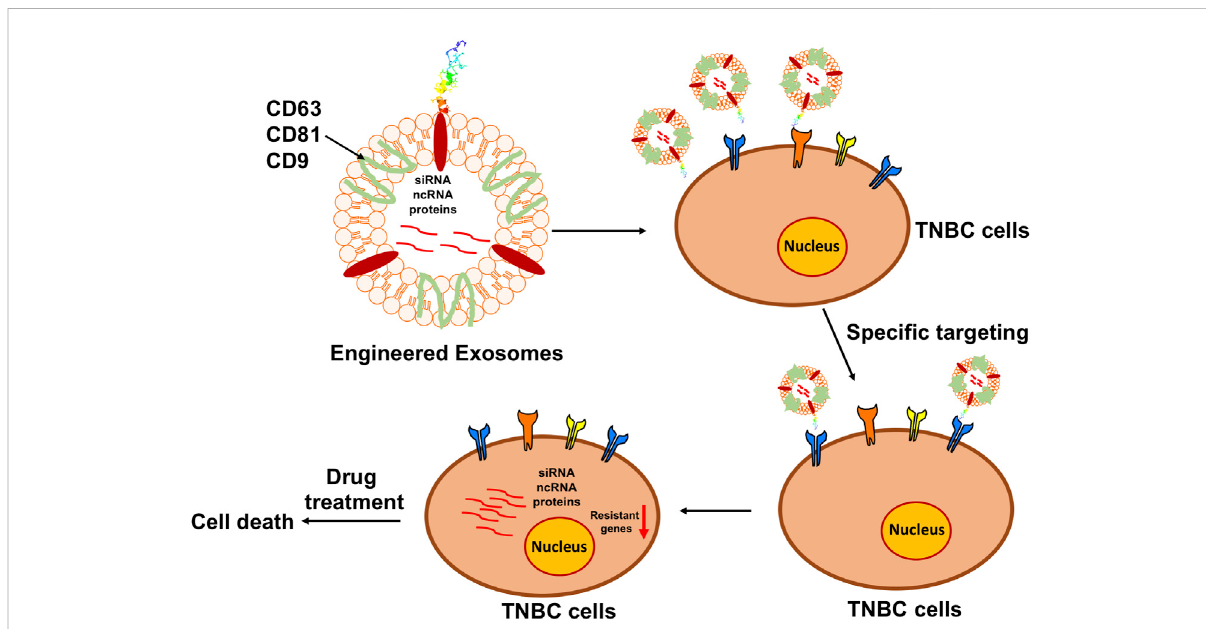
FIGURE 3 Diagram of the principle of engineering exosomes to facilitate chemotherapy. Based on the bioengineering techniques, the surface of exosomes can be modi fi ed with the designed ligands to precisely target the speci fi c markers on the surface of TNBC cells, while the interior can be loaded with the functional anti-tumorigenesis cargoes to prevent the progression of